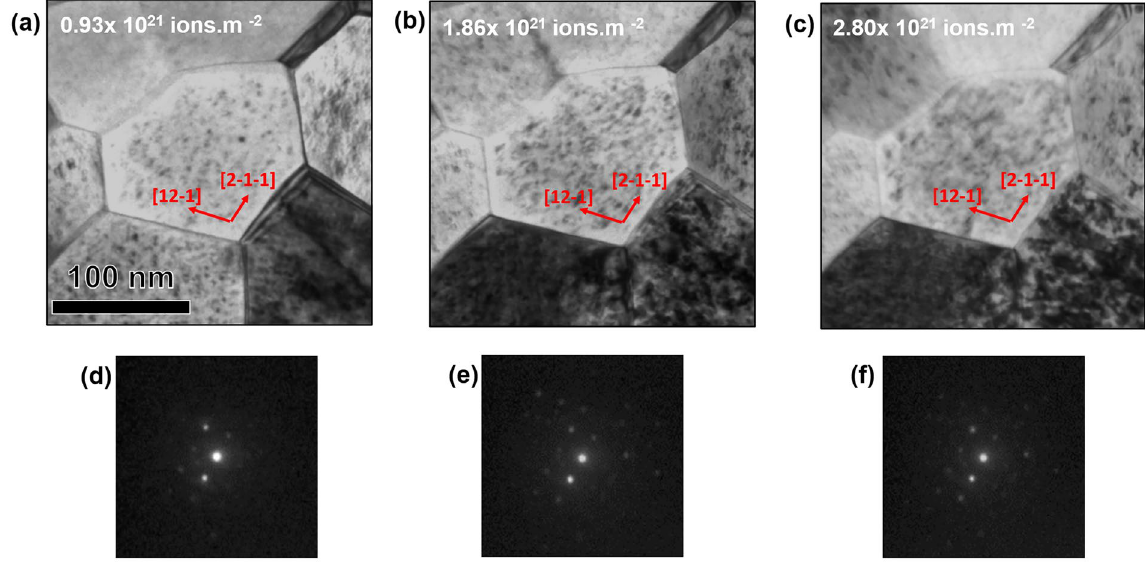
Figure 2. ( a ), ( b ) and ( c ) Bright-field TEM images of grain I (Fig. 1a) irradiated with 10 keV He at 573 K to 0.93, 1.86 and 2.87 × 10 21 ion.m − 2 respectively with g vectors of the imaging conditions. ( d ), ( e ) and ( f ) the corresponding diffraction pattern extracted from ACOM demonstrating no change in the diffraction condition during irradiation.